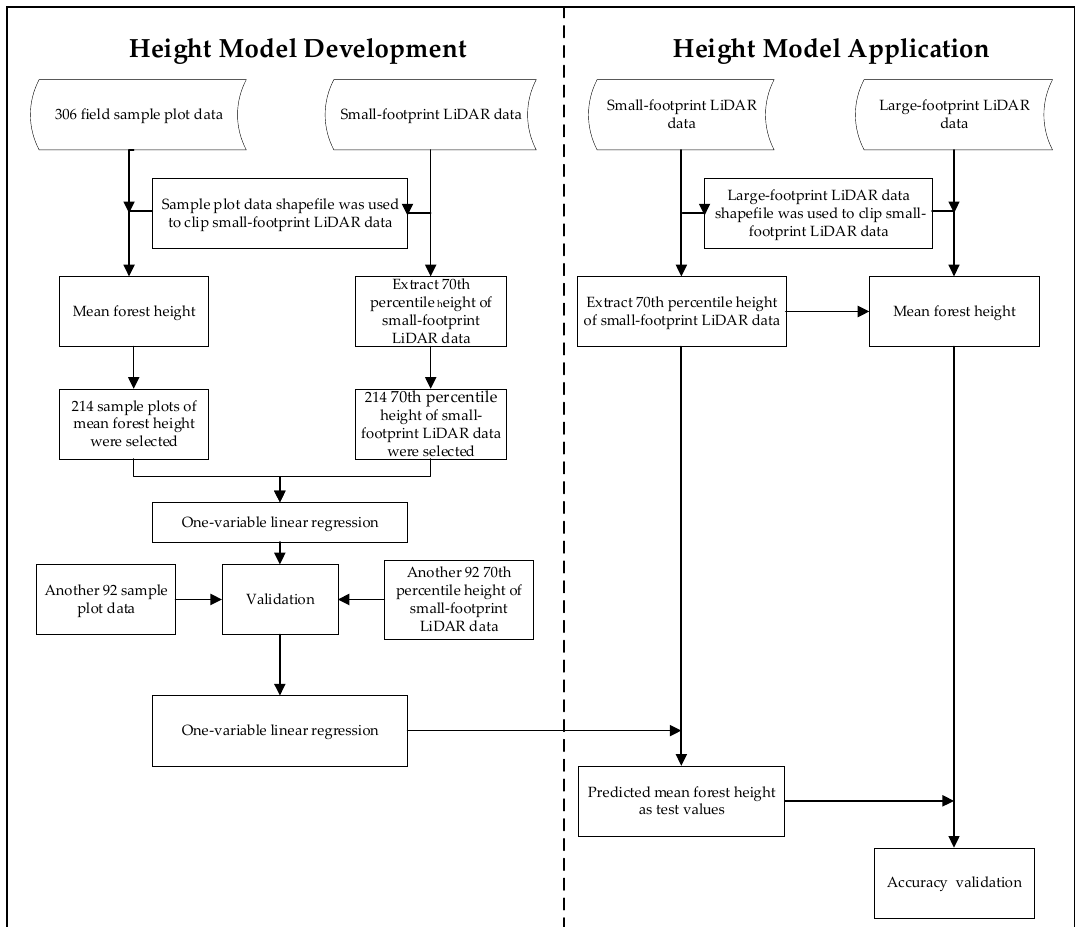
Figure 10. Overview of height modeling and validation process for the estimation of mean forest height.